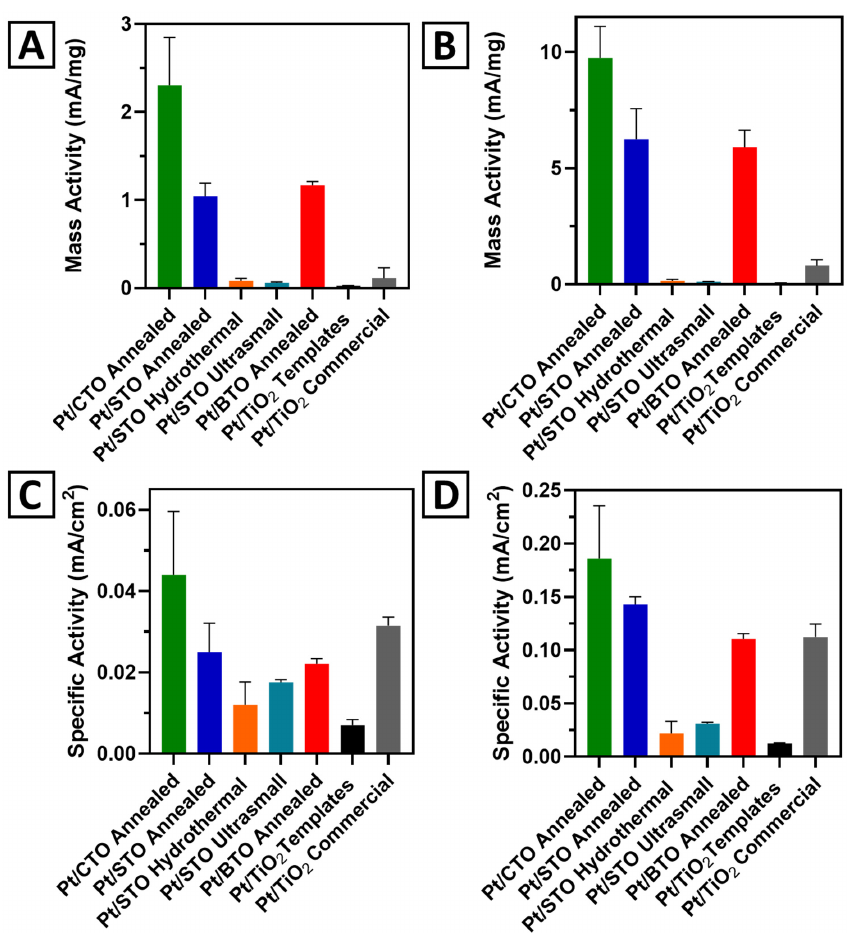
Figure 10. Bar graphs of ( A ) MA at 0.7 V, ( B ) MA at 0.8 V. ( C ) SA at 0.7 V, and ( D ) SA at 0.8 V, respectively, for all ATO samples and standards.